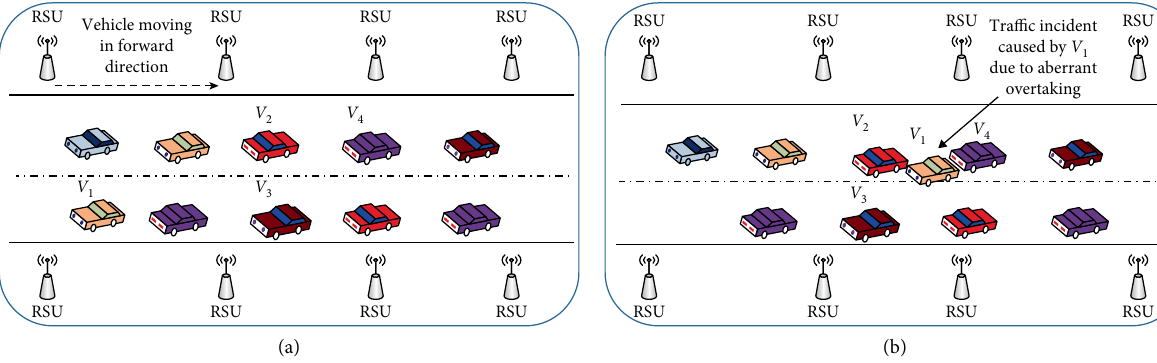
Figure 2: Traffic incident scenario. (a) Movement of vehicle in the forward direction, and (b) movement of vehicle with aberrant